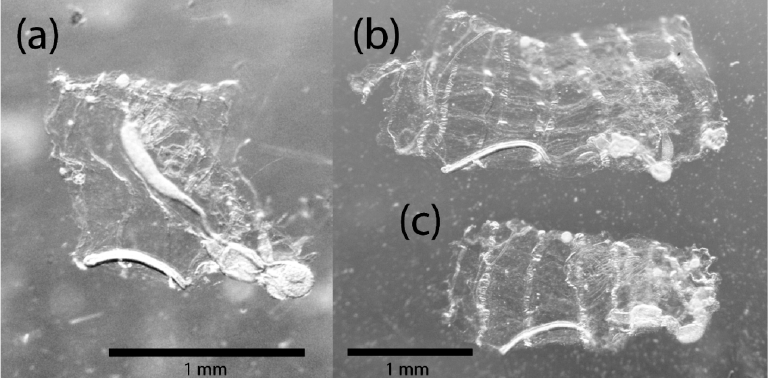
Figure 3. Photographs of Dolioletta advena sp. nov. individuals from which DNA was isolated and COI sequences were obtained. ( a ) gonozooid, isolate dcgen, ( b ) phorozooid, isolate gega, ( c ) phorozooid, isolate gegb.